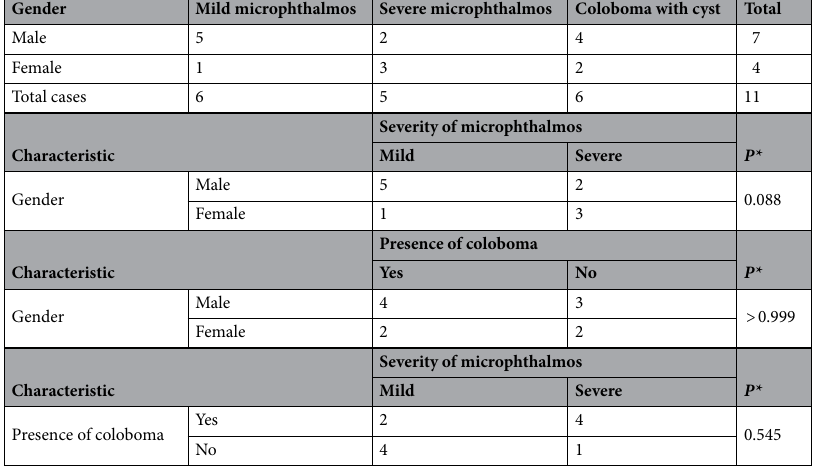
Table 1. Distribution of 11 cases of microphthalmos according to gender, severity of microphthalmos and presence of coloboma (with cyst) with correlation between gender and severity of microphthalmos/presence of coloboma and correlation between severity of microphthalmos and coloboma. *Fisher’s exact test of